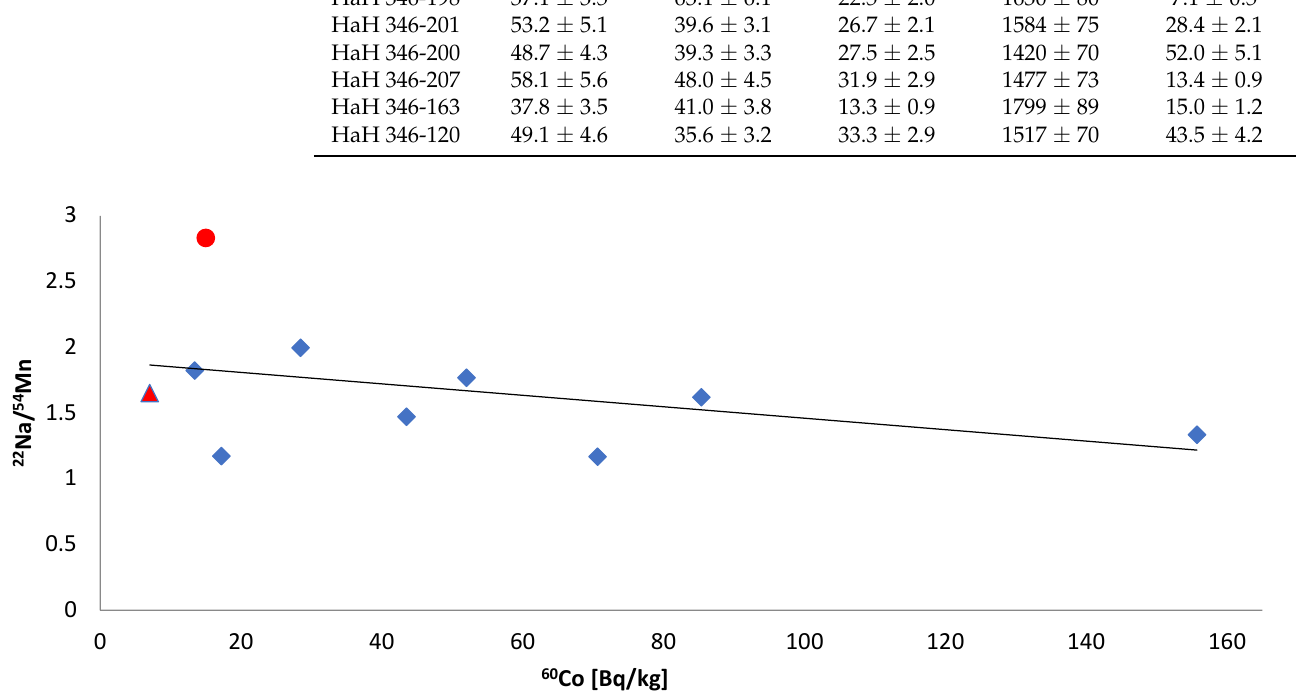
Figure 5. 54 Mn and 22 Na activity ratio in function of 60 Co as indicators of terrestrial age of chondrites [dpm/kg], red circle—HaH 346-163 and red tringle—HaH 346-198, blue rhombus—other samples. The variation in 60 Co activity (from ~7 to ~156 dpm/kg) can be explained by variations in the shielding depth within a meter-sized object; therefore, samples with code HaH 346-198 and HaH 346-163 represent fragments from shallow depths. These depth variations also affect the production of 22 Na and 54 Mn isotope concentrations.